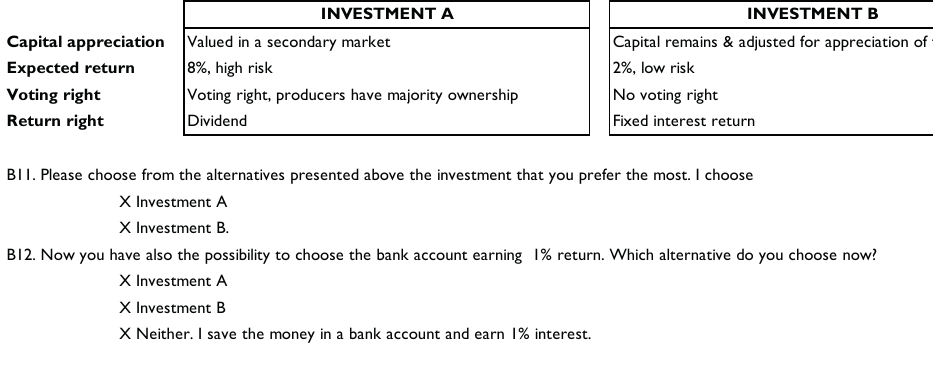
Fig. 1. Example of a choice